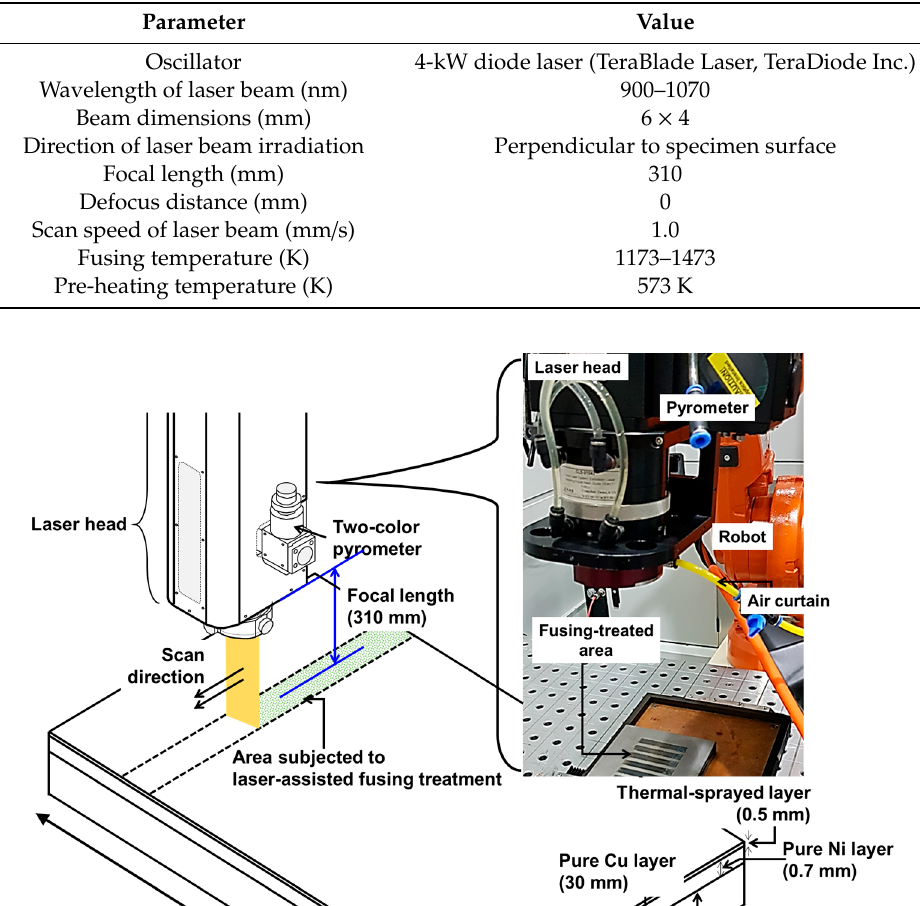
Table 3. Laser-assisted fusing treatment conditions.